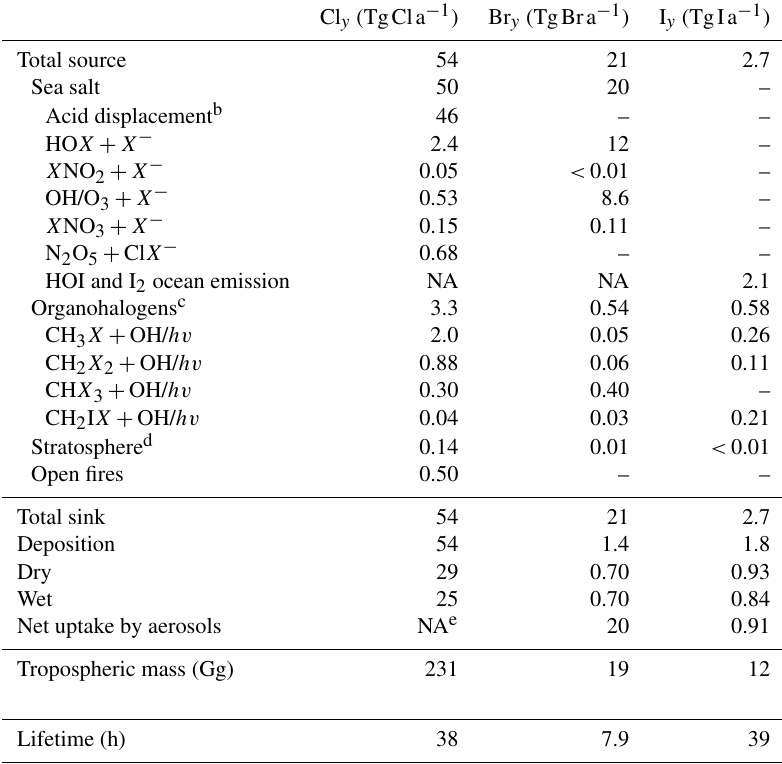
Table 1. Global sources and sinks of tropospheric gas-phase inorganic chlorine (Cl y ), bromine (Br y ), and iodine (I y ) a